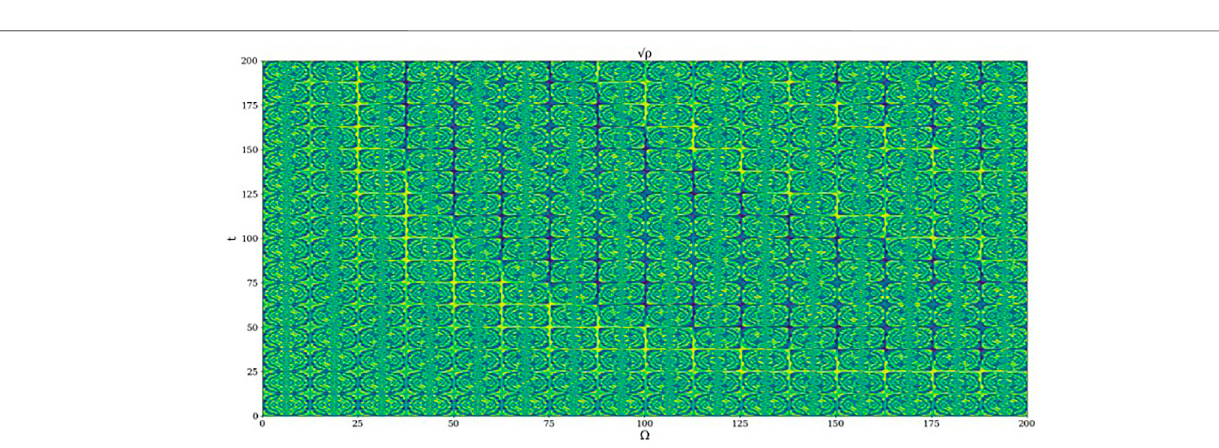
FIGURE 10 | Example 2D plot of the alternative equation of